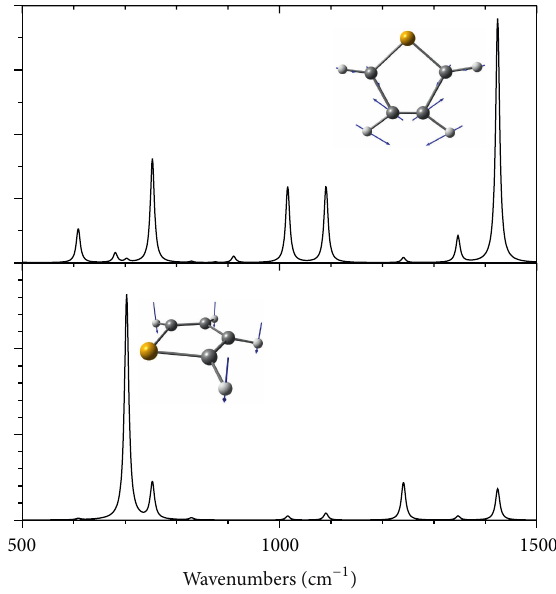
Figure 5: B3LYP/6-311G ∗∗ anharmonic IR (bottom) and Raman (top) spectra of C 4 H 4 Se in the 500–1500 cm −1 wavenumber range. Lorentz line shapes with half-width of 10cm −1 were used.